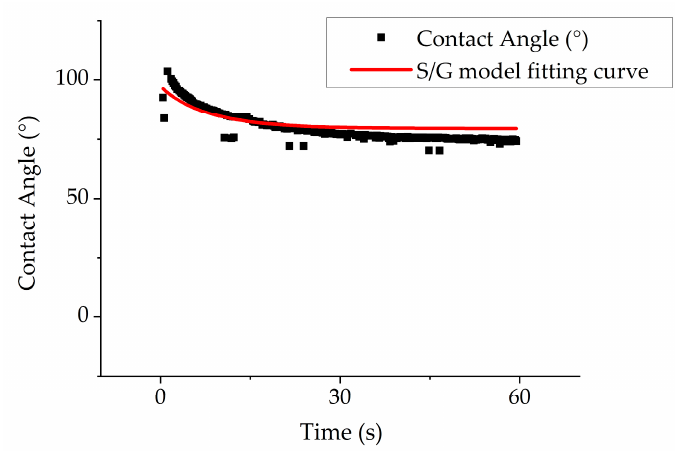
Figure 9. S/G model fitting curve of glycerol contact angle (Sample 5).